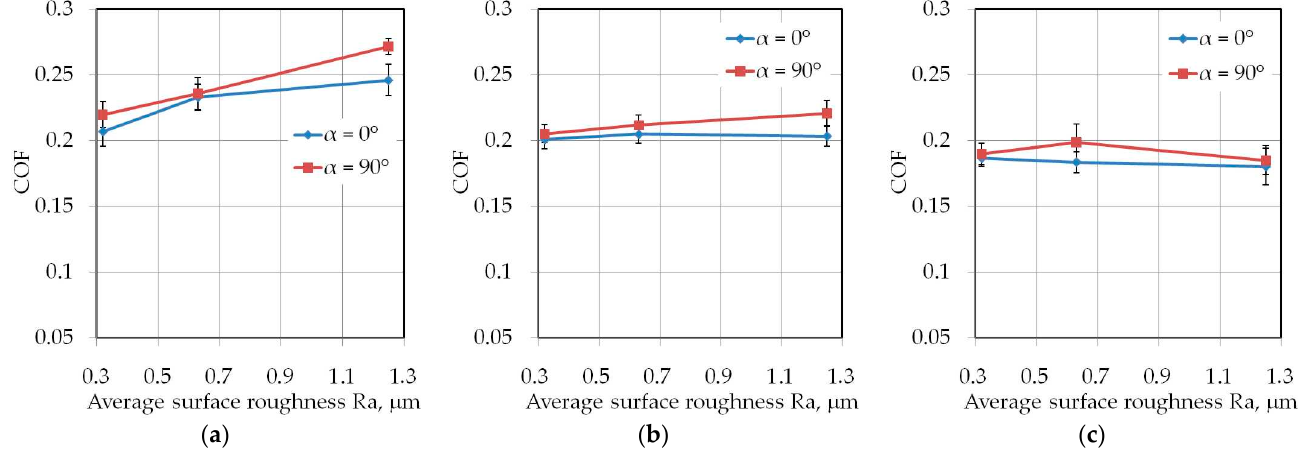
Figure 13. The effect of the sample orientation on the value of COF for specimens with a width of 14 mm tested at dry friction conditions: ( a ) h = 6 mm, ( b ) h = 12 mm, ( c ) h = 18 mm.